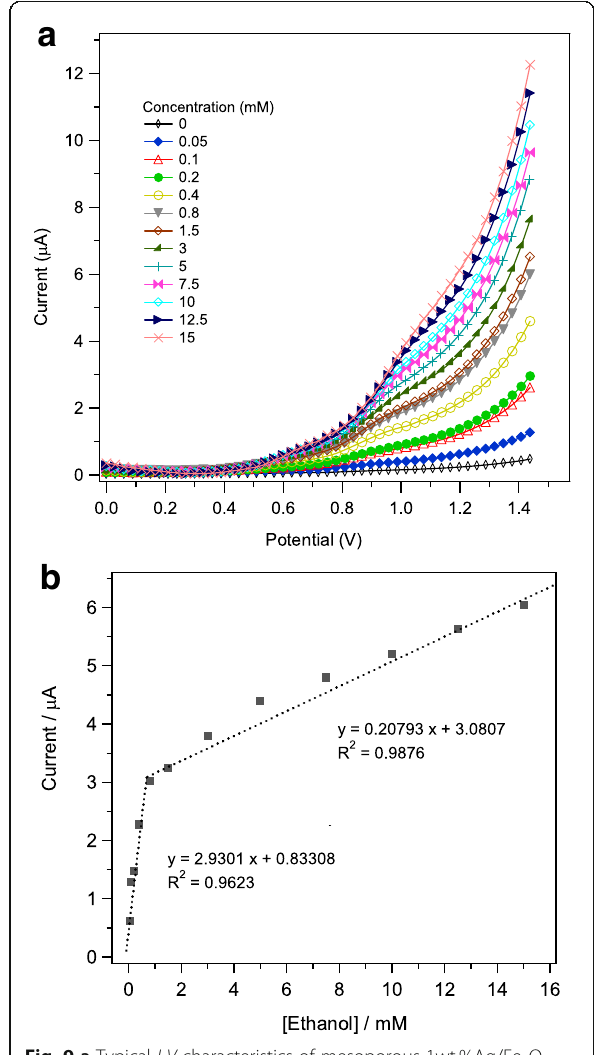
Fig. 9 a Typical I-V characteristics of mesoporous 1wt.%Ag/Fe 2 O 3 - modified GCE toward various concentrations of ethanol (from 0.05 to 15 mM), measured in 0.1 M PBS solution (pH = 7) and b the corresponding calibration plot